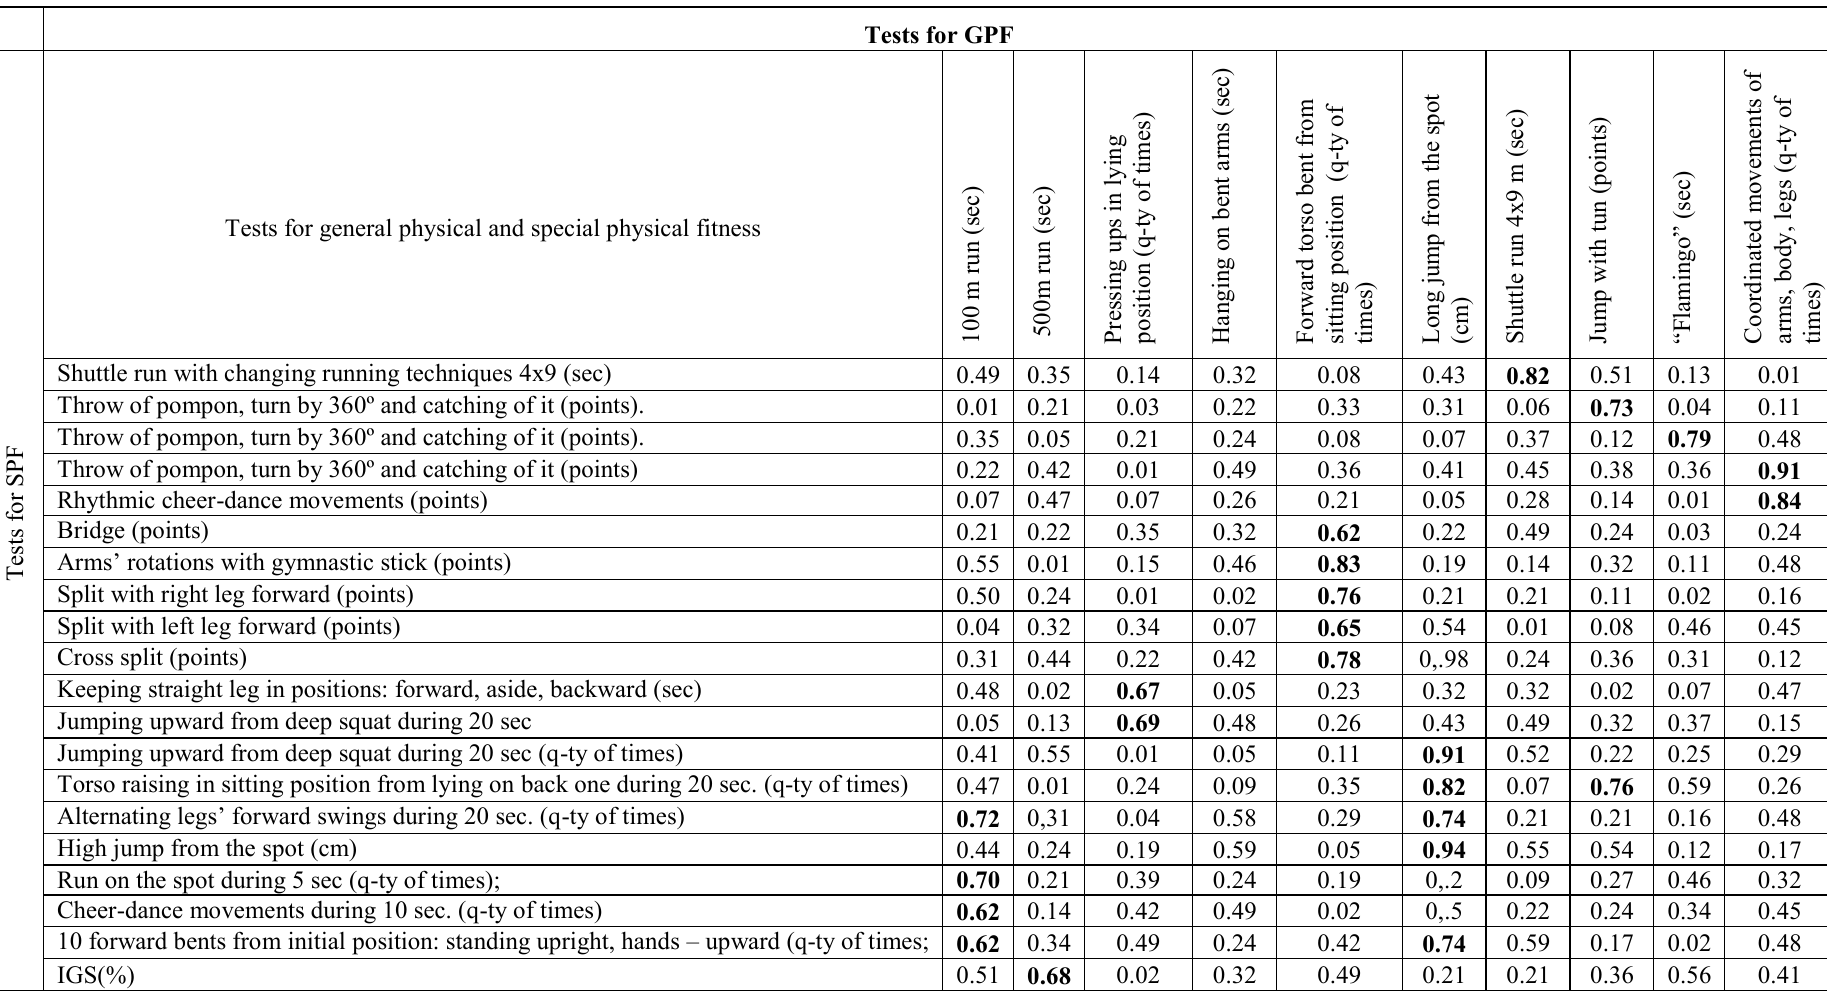
Correlation matrix of interconnection of general physical and special fitness’s indicators of cheerleaders (n=14;